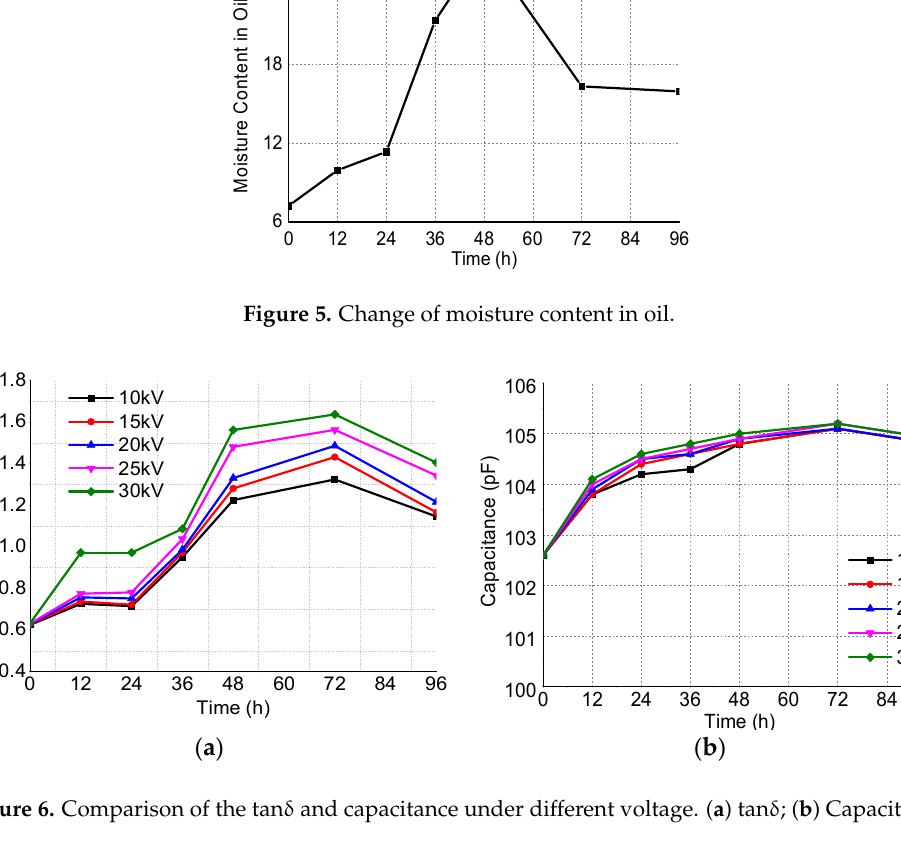
Figure 5. Change of moisture content in oil.